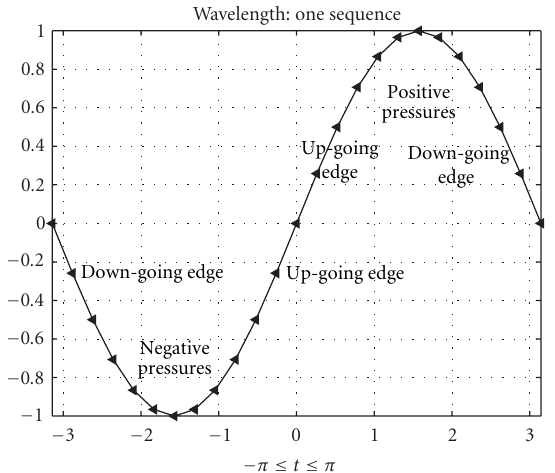
Figure 4: We show here the partition of one sequence of sinusoidal curve; this sequence can be a wavelength of intralabyrinthine pressure P i ( t ), intracranial pressure P c ( t ), or modulation pressures between P i ( t ) and P c ( t